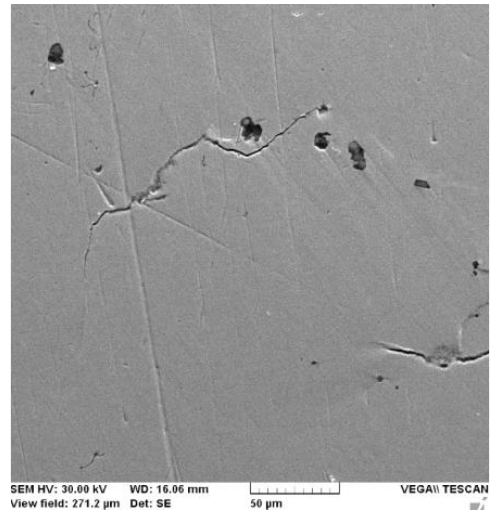
Figure 2. Ni-Cr surface corrosion cells. (WD — working distance — the distance between sample surface and the lower end of the pole piece where the electrons are coming from; HV — accelerated energy; SE — detector)